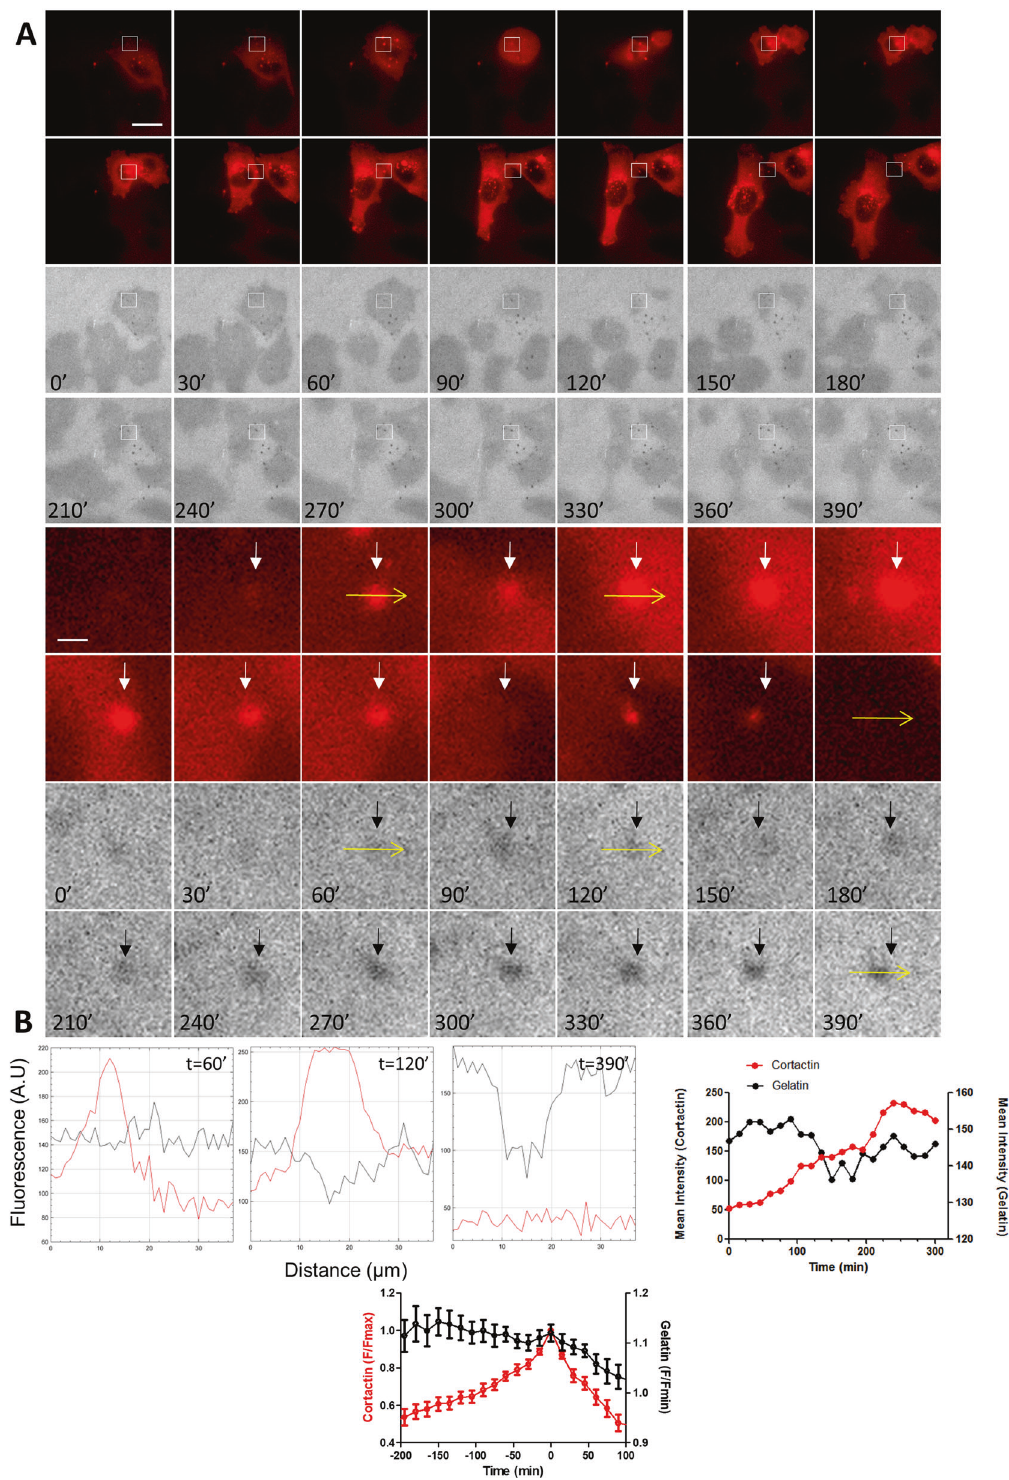
Fig. 4 Time-lapse imaging of Cortactin-dsRed revealed biphasic Cortactin appearance at active invadopodia. A Dual time-lapse images of Cortactin-dsRed and Cy3-Gelatin were taken every 15 min for 24 h; representative images are shown every 30 min. Insets show magni fi ed views of active invadopodia in the cortactin channel (white arrows) and the gelatin channel (black arrows) Scale bar: 10 µm. B Graphs indicate fl uorescent intensity in arbitrary units (A.U.) of Cortactin-dsRed (Red), and Cy3-gelatin (black) over the indicated yellow line scan in the inset at t = 60, 120 and 390 min. Note high fl uorescence intensity of Cortactin-dsRed (left) at invadopodia before degradation ( t = 60), a second increase in fl uorescence intensity after degradation ( t = 120) and the return to background levels after degradation ( t = 390). Right graph represents the mean intensity of Cortactin-dsRed and Cy3-gelatin fl uorescence over time of this example. Bottom graph represents the mean F / F F / F max intensity ± SEM of Cortactin-dsRed and min intensity ± SEM of FITC-gelatin over time from 30 invadopodia. For each invadopodia, T = 0 was de fi ned as the maximal fl uorescence intensity of cortactin. Cell Death and Disease (2023)